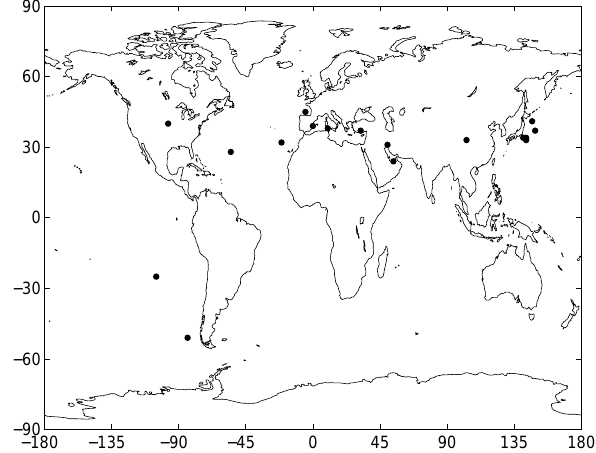
Fig. 1. Lightning discharges with particularly large optical intensi- ties (black dots) occur primarily in coastal areas (Turman, 1977).